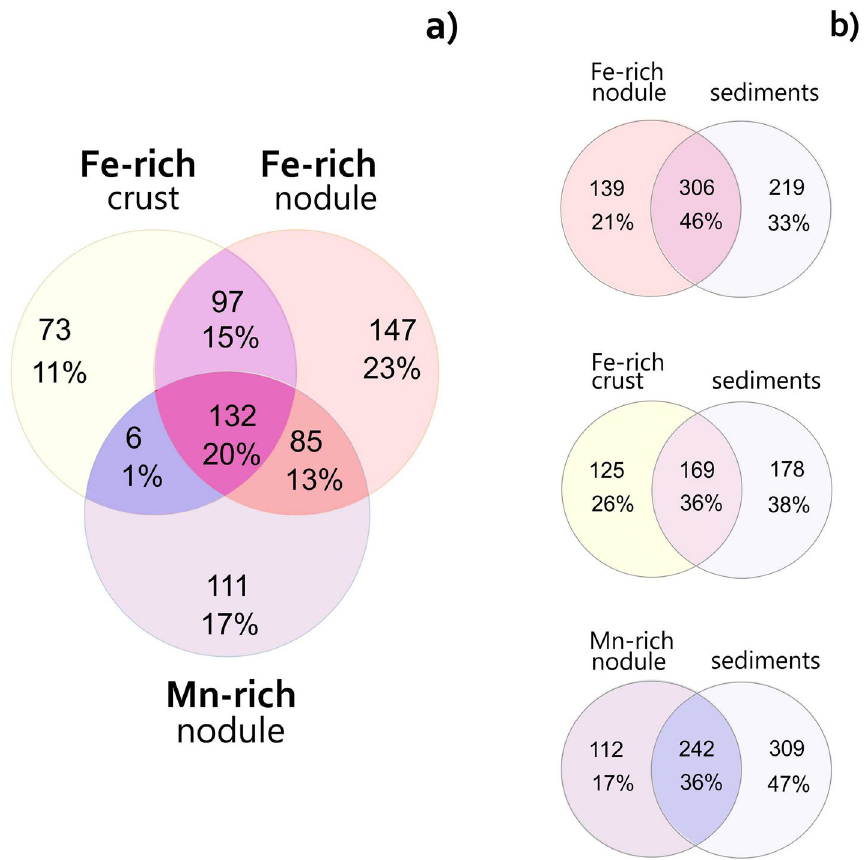
Figure 5. Venn diagram showing the distribution of unique OTUs and the number of shared OTUs (overlapped regions) between Fe-rich crust (site AMK79-6236), Fe-rich nodule (site PSh128.35) and Mn-rich nodule (site AMK79-6259); (a) comparison of three different Fe-Mn deposits; (b) pairwise comparison of the Fe-Mn deposits and their underlying sediments.